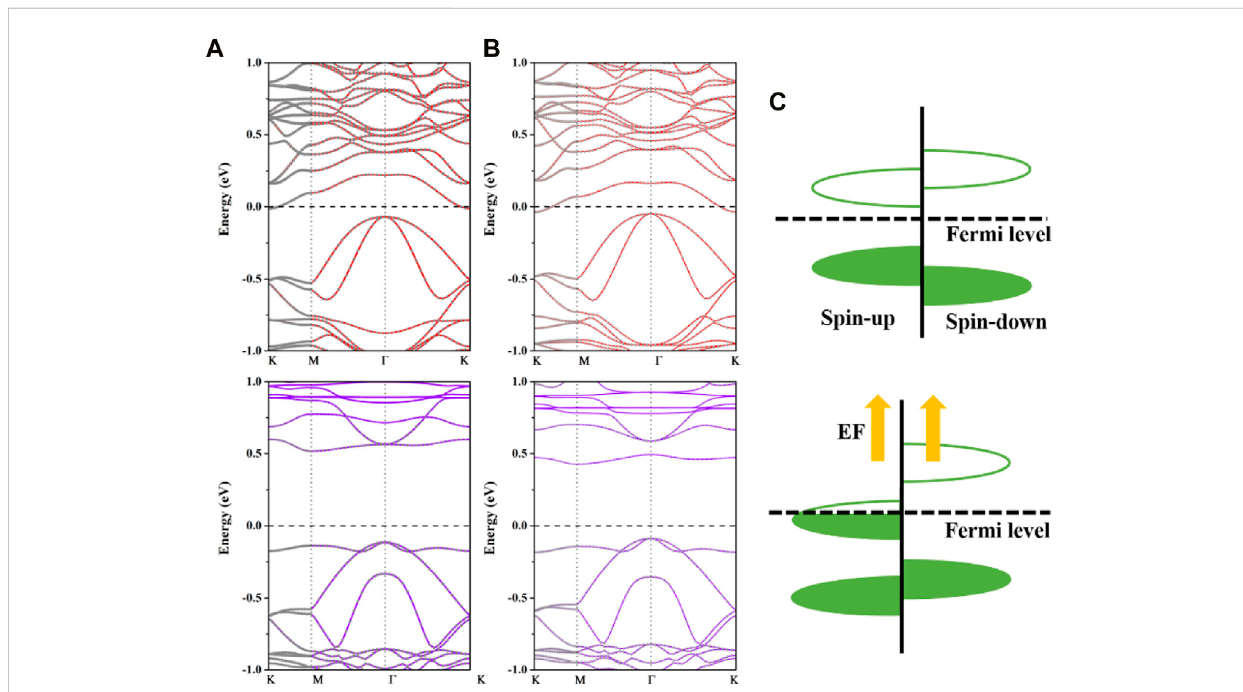
FIGURE 7 The calculated projected spin-up and spin-down band structures of Cr 2 Ge 2 Te 6 @Mn with electric fi elds of (A) 0.1 and (B) 0.6 V/Å. In the band structures, the solid red lines correlate to the spin-up, while the solid purple lines correspond to the spin-down. The solid grey circles in the spin-up and spin-down band structures correspond to the contribution from the Cr 2 Ge 2 Te 6 layer. The Fermi level is set to zero. (C) A schematic illustration of the electric fi eld-induced transition from a ferromagnetic semiconductor to a half